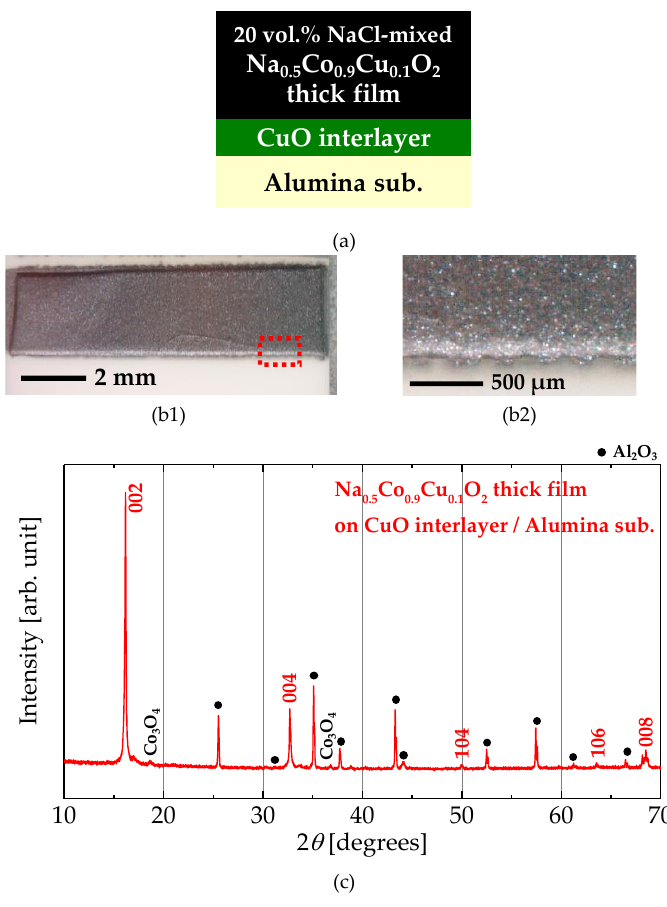
Figure 4. ( a ) Cross-sectional schematic of a Na 0.5 Co 0.9 Cu 0.1 O 2 thick film prepared by the improved process. ( b1 , b2 ) Photographs of the Na 0.5 Co 0.9 Cu 0.1 O 2 thick film; ( b1 ) shows the entire film and ( b2 )